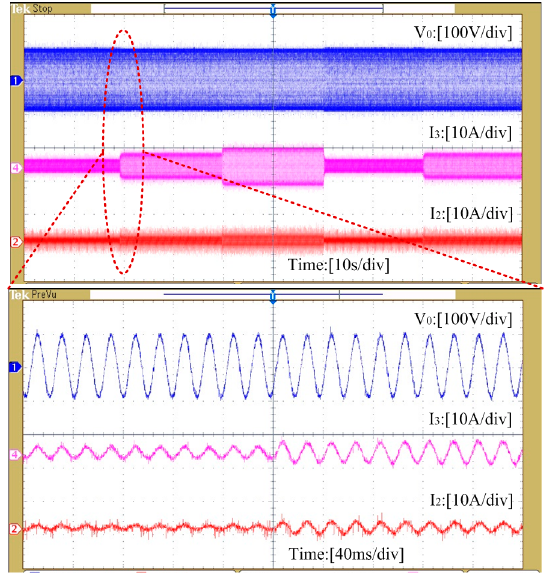
Figure 16. Experimental voltage and current waveforms.